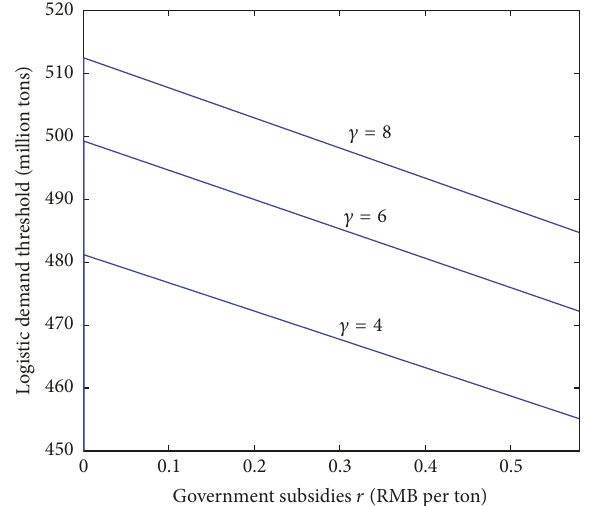
Figure 6: Change of the logistics demand threshold with govern- ment subsidies.